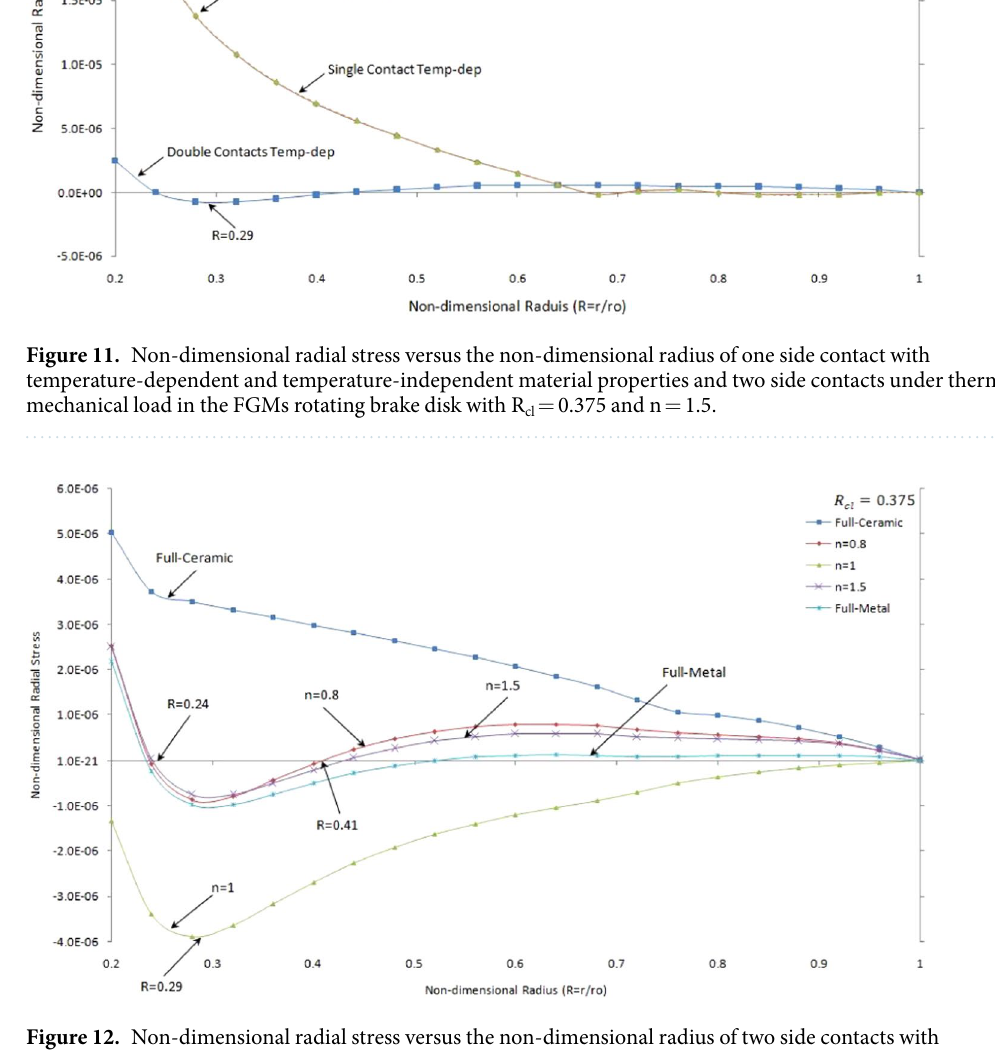
= 0.375 and different values of the grading index, n . cl